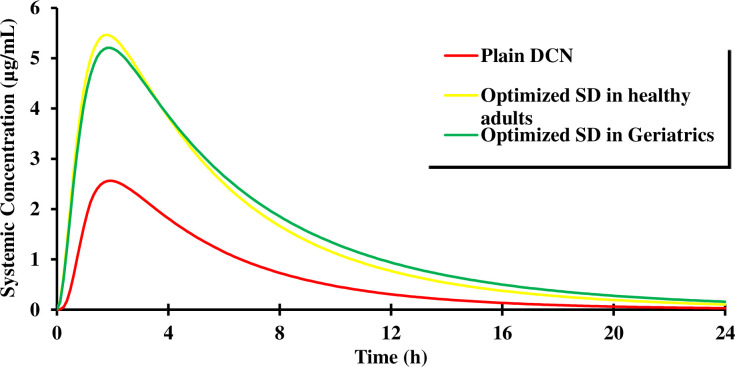
Physiologically based pharmacokinetic (PBPK) model–simulated DCN plasma concentration-time curves following oral administration of optimized SD and plain DCN in healthy adults and geriatrics.